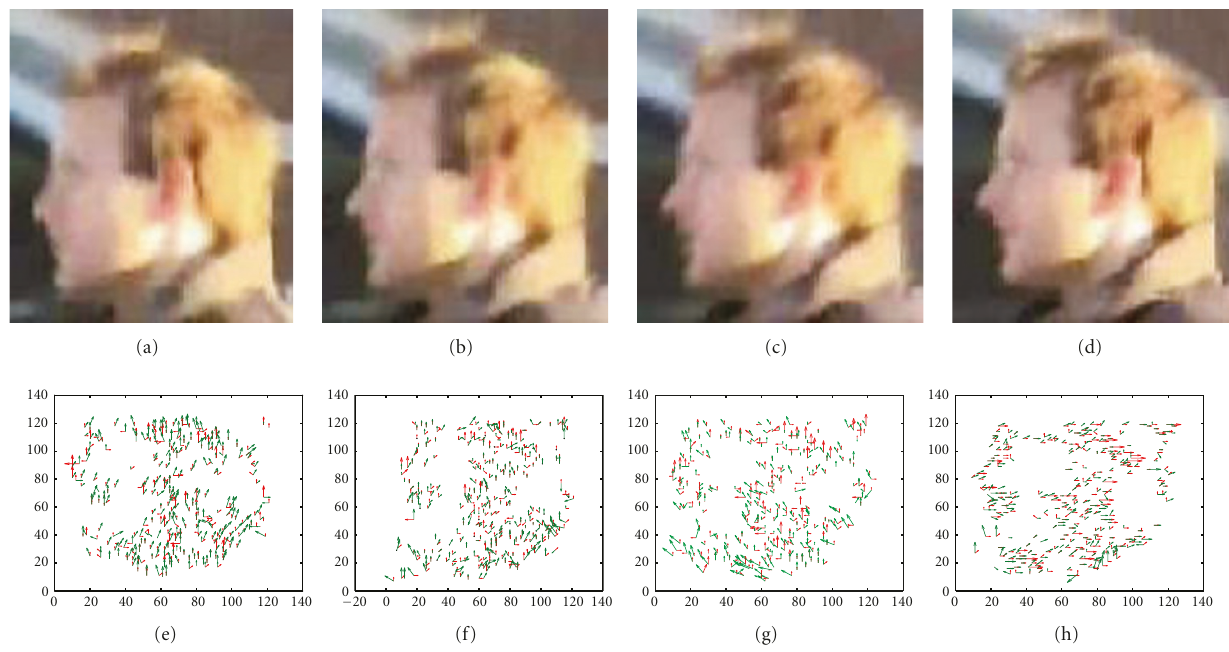
Figure 3: Top row: frames from the video. Bottom row: scaled flow vectors. Green: Lucas-Kanade. Red: our